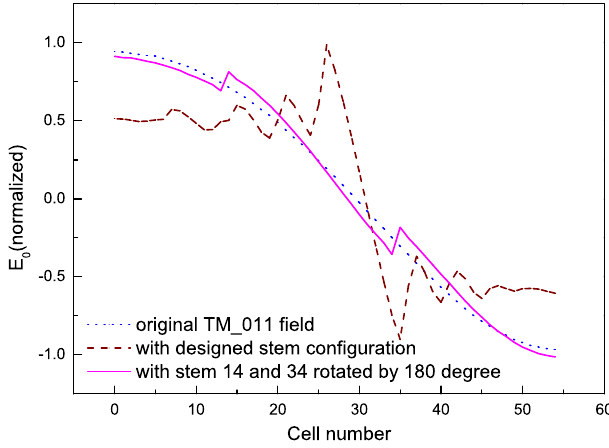
FIG. 17. Longitudinal electrical field strength of the TM 011 - mode as a function of the cell number for an Alvarez-type cavity for three different cases: original constant V-configuration of stems (blue), original constant V-configuration with the stem pairs of cell 14 and 34 being rotated by 180 degrees (purple), and final stem configuration after optimisation with respect to local field flatness as shown in Fig. 18.